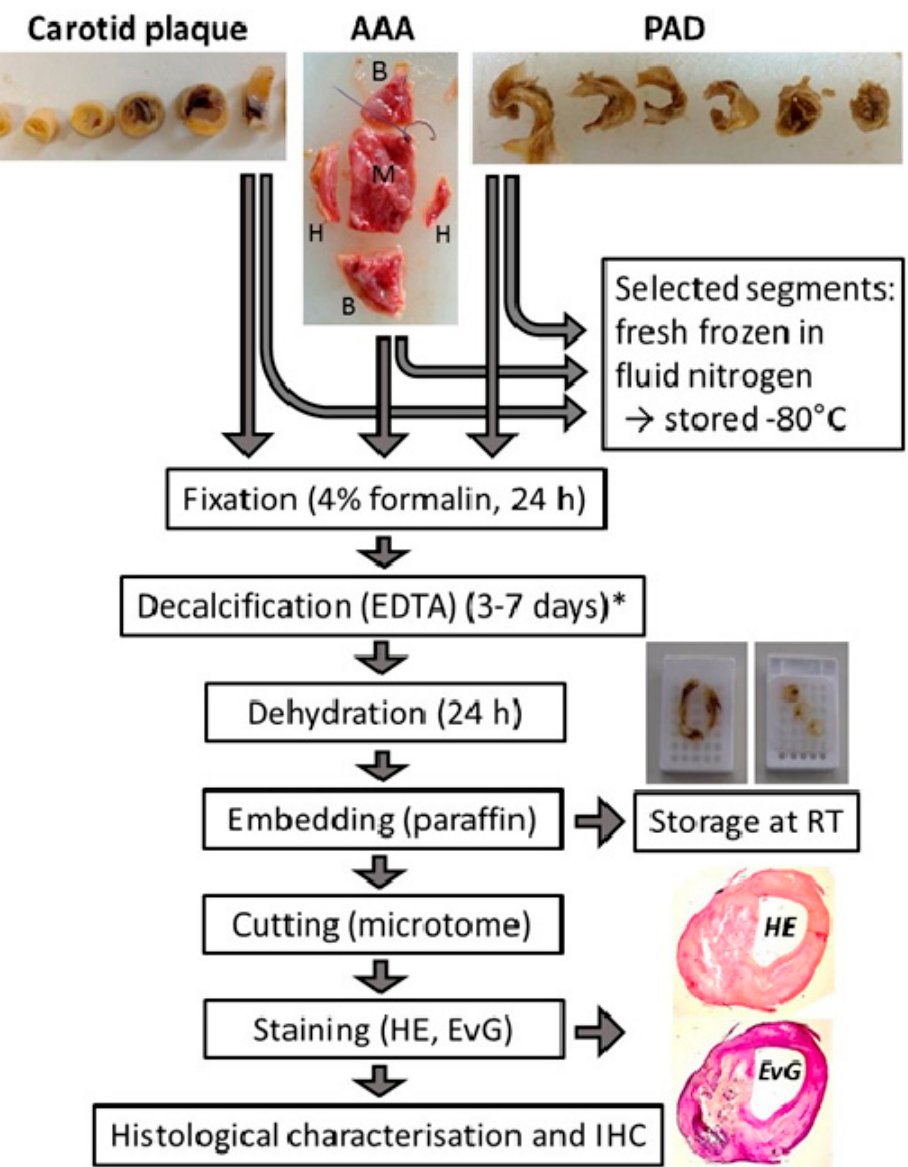
Figure 3. Schematic chart of the processing of vascular tissue after surgical excision. Carotid plaque: atherosclerotic lesions from patients with high-graded carotid artery stenosis; AAA: aortic wall from patients with abdominal aortic aneurysm; PAD: atherosclerotic tissue from patients with peripheral artery disease; RT: room temperature; IHC: immunohistochemistry. HE: haematoxilin-eosin staining; EvG: elastica van gieson staining; * the time depends on the extent of calcification.